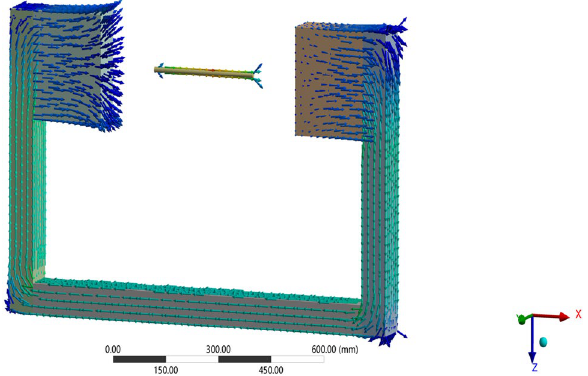
Fig. 6 Force-magnetic coupling simulation